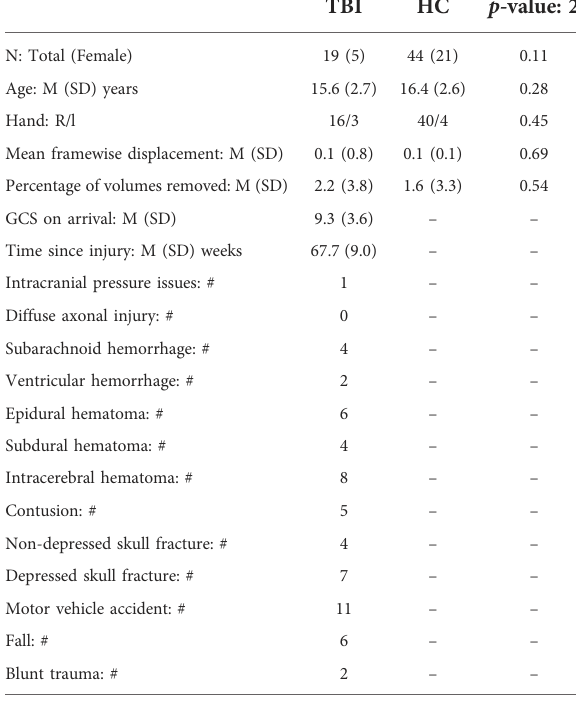
TABLE 1 Demographic and clinical variables for TBI and HC